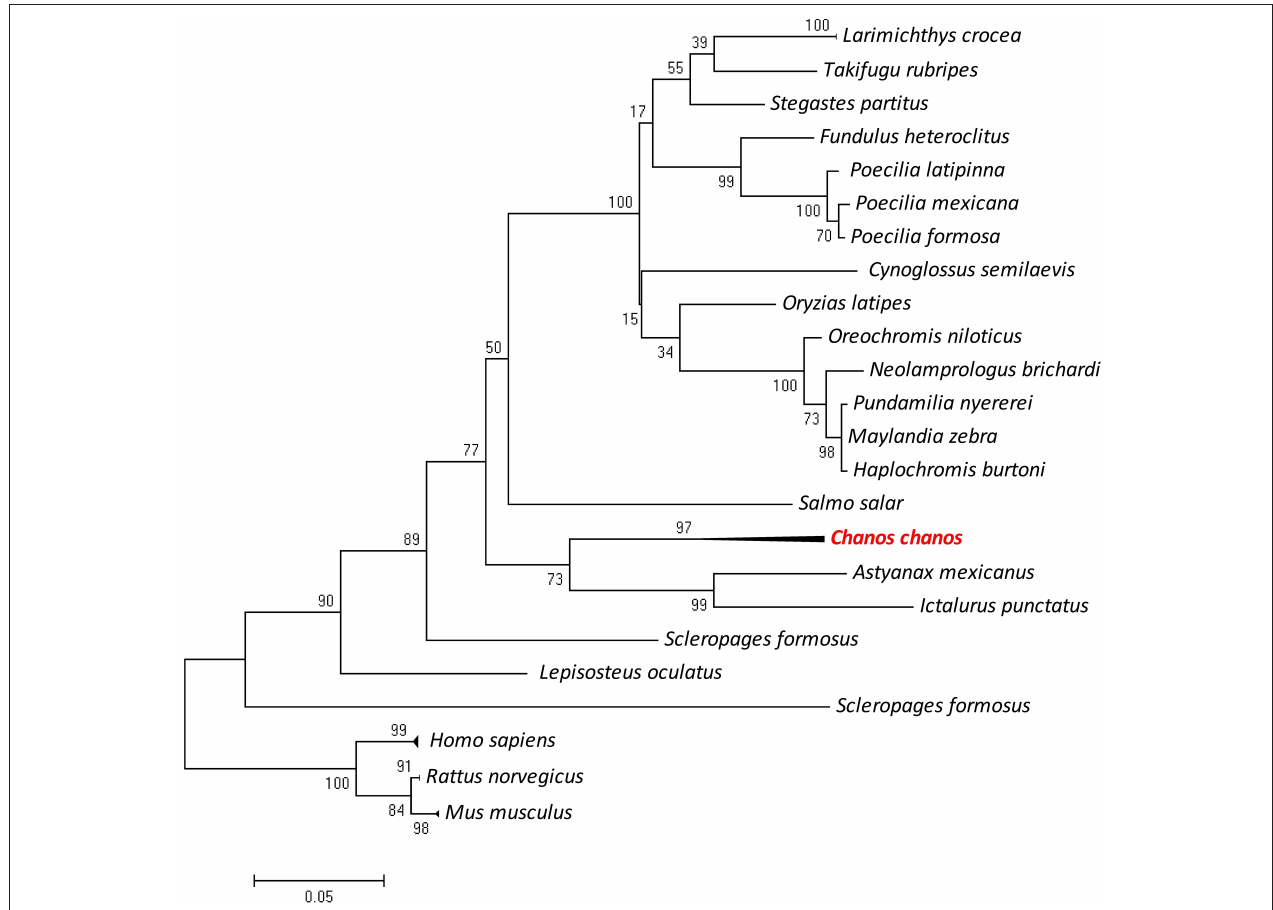
FIGURE 2 | Phylogenetic analysis of milkfish ( Chanos chanos ) liver isoform of glycogen phosphorylase (Pygl) proteins based on amino acid sequences using the maximum likelihood method. The results were confirmed by 1000 bootstraps. Sequence accession numbers of different proteins are listed in Table 2 .